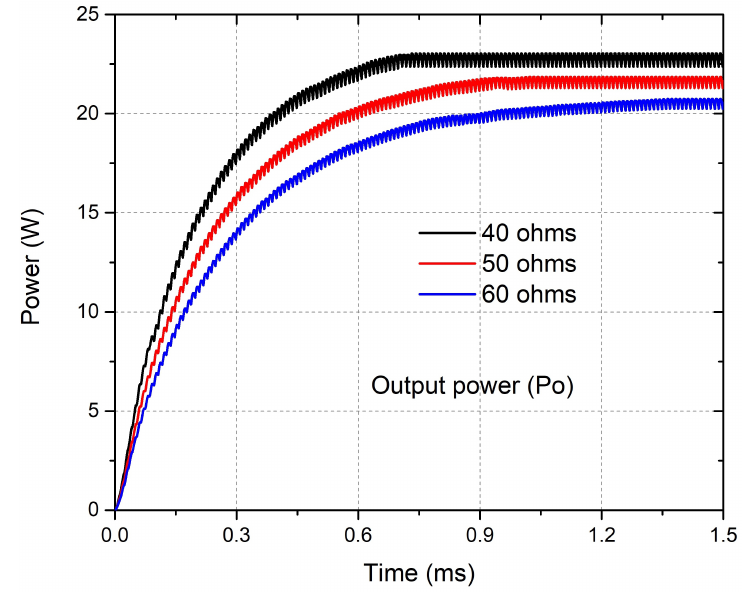
Figure 20. Output power plot using the proposed